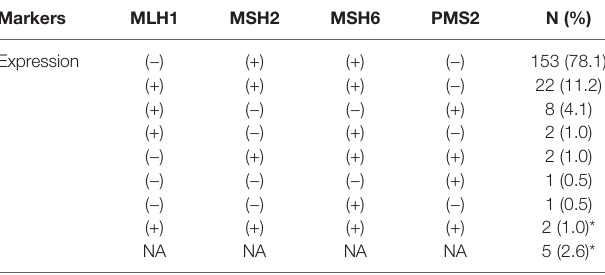
TABLE 2 | The detail of expression pattern of 196 dMMR/MSI-H cases. Markers